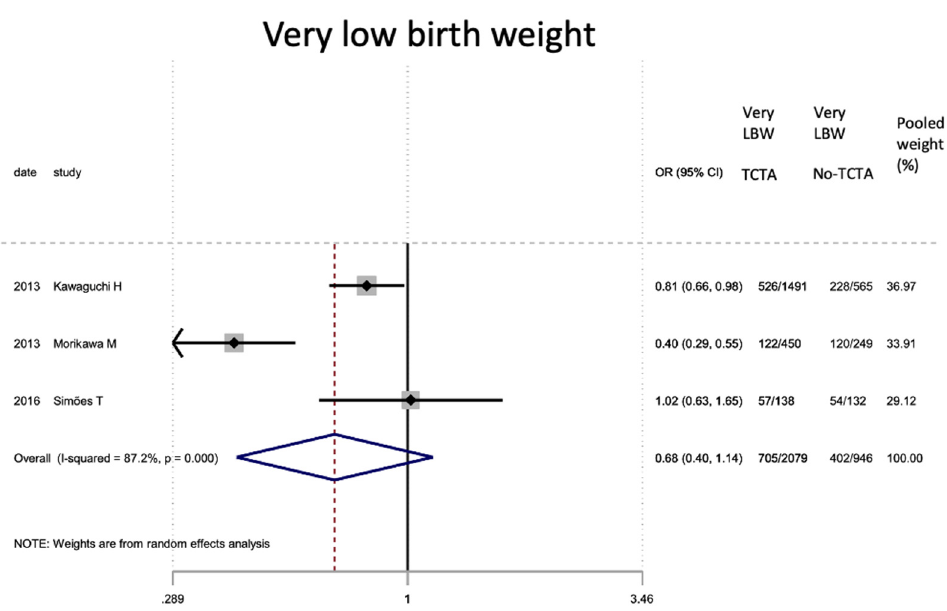
Figure 5. Results of the meta-analysis on the effect of chorionicity (TCTA vs no TCTA) on very preterm newborns (under 32 weeks). Very Prem: very premature; TCTA: trichorial-triamniotic, non- TCTA: non-trichorial-triamniotic. OR = odds ratio, CI = confidence interval.